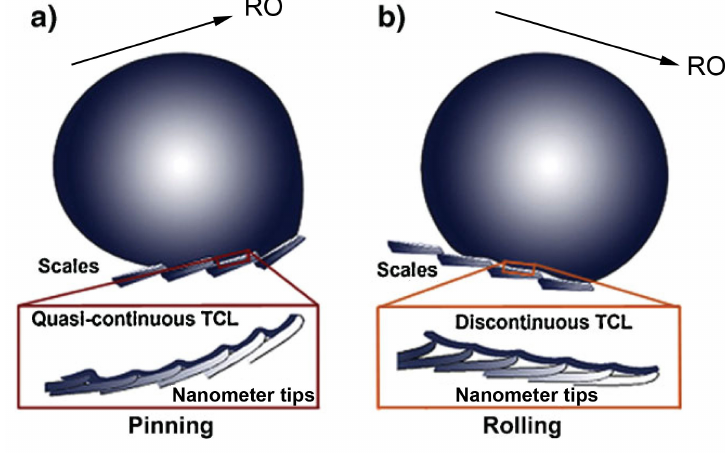
Figure 8. Directional adhesion of water on superhydrophobic Morpho aega butterfly